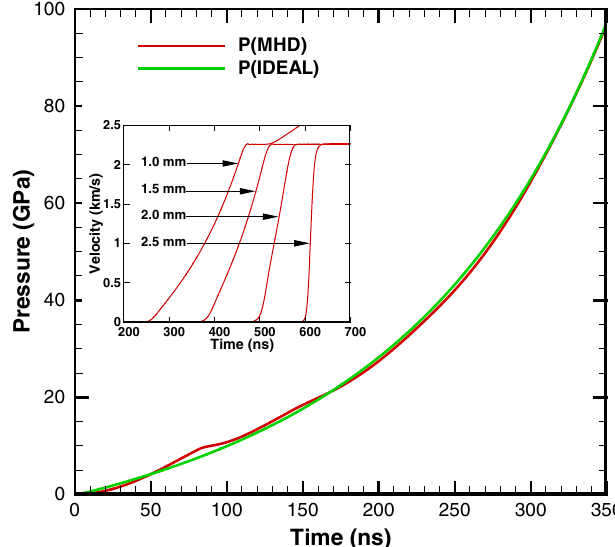
FIG. 15. Ideal and MHD code-calculated pressure drive for shockless compression of copper. Inset shows copper-LiF inter- face velocities for the tailored pressure pulse. Ramp loading is ¼ 2 . 4 mm. maintained until sample thickness is X C